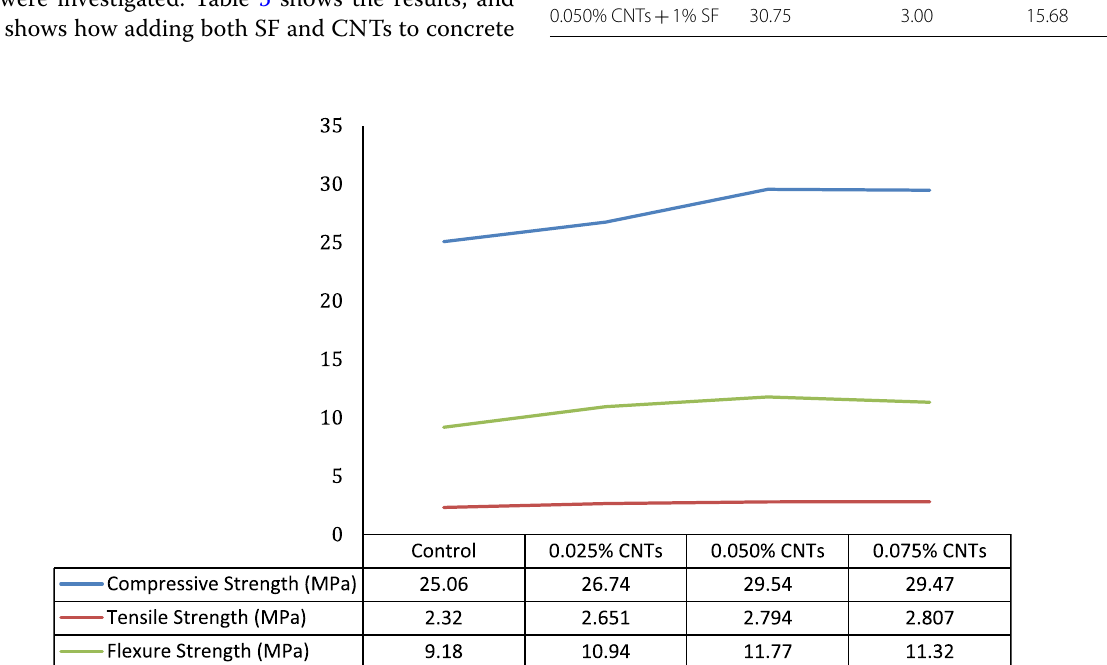
Fig. 12 Compressive strength, tensile strength, and flexure strength of the control and concrete containing CNTs